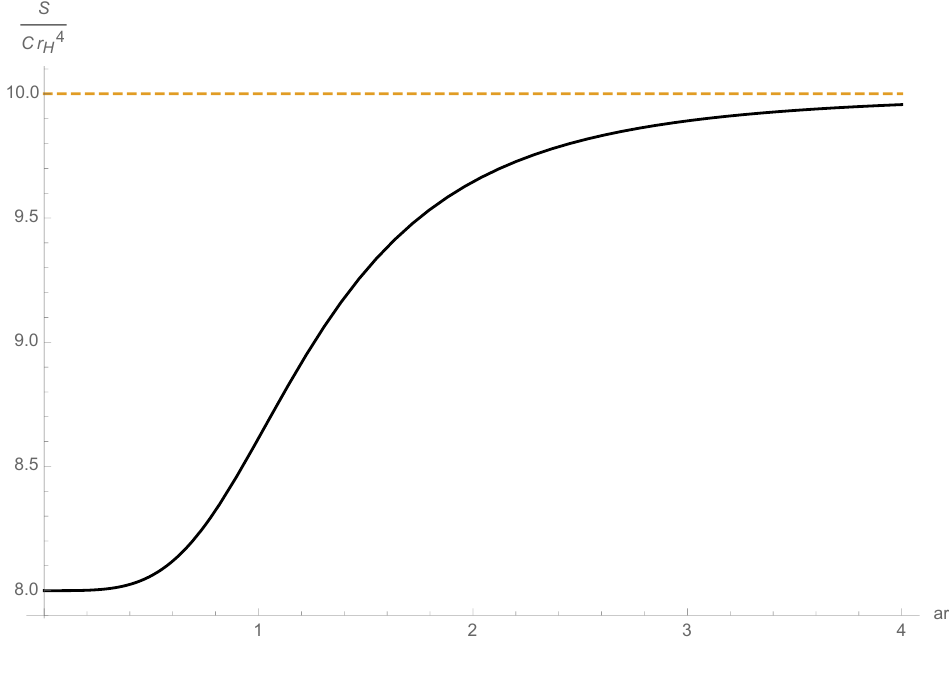
Figure 2 . Late time action growth rate normalized by C = (cid:11) 4 (cid:10) 5 V 3 versus ar H , which is the Moyal scale measured in units of thermal length. It is observed that the complexi(cid:12)cation rate under the CA conjecture increases signi(cid:12)cantly when the Moyal scale is comparable to the thermal scale, and saturate a new bound which is 5/4 of the commutative value when the Moyal scale is much larger than the thermal